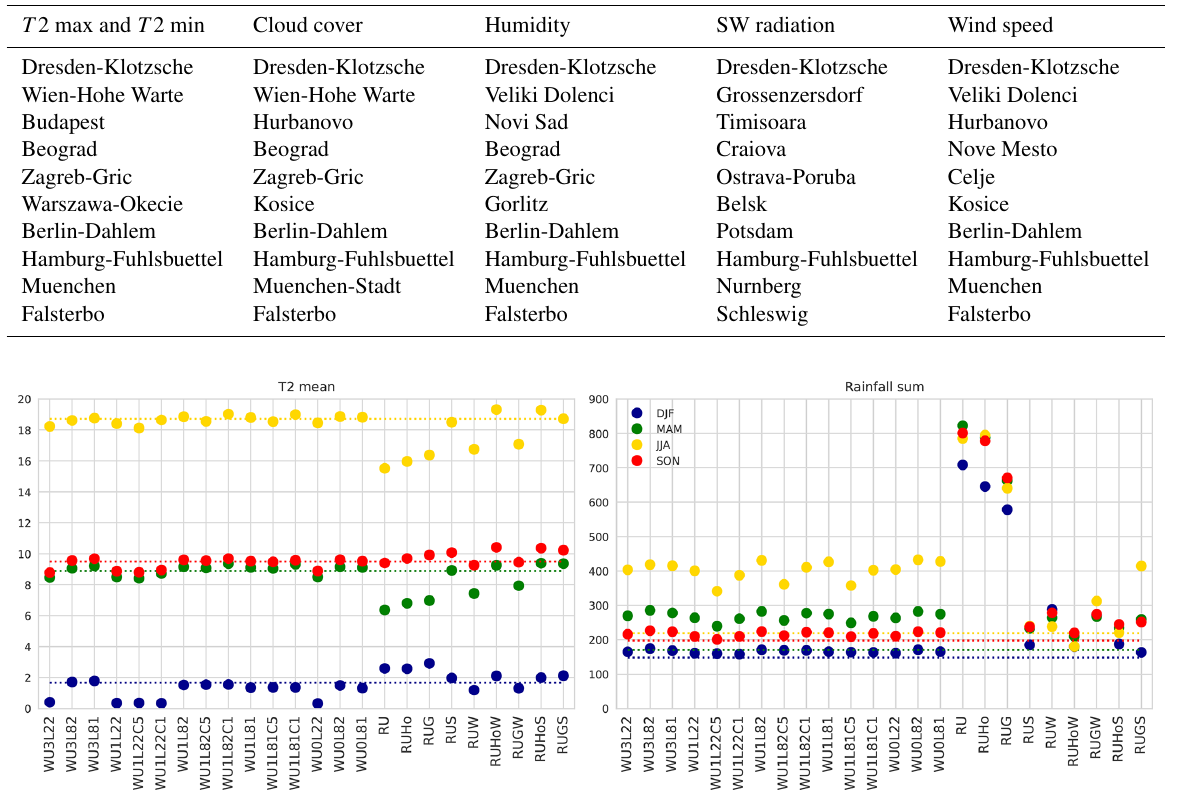
Figure 3. Domain-averaged seasonal 2m air temperatures ( ◦ C) and accumulated precipitation (mm) for individual simulations and E-OBS data (dotted